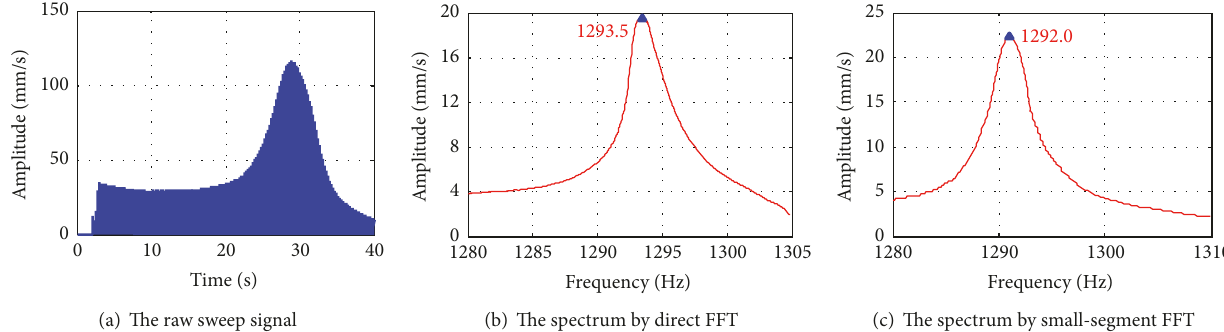
Figure 5: The 5th natural frequency of TCS obtained by different FFT processing techniques.